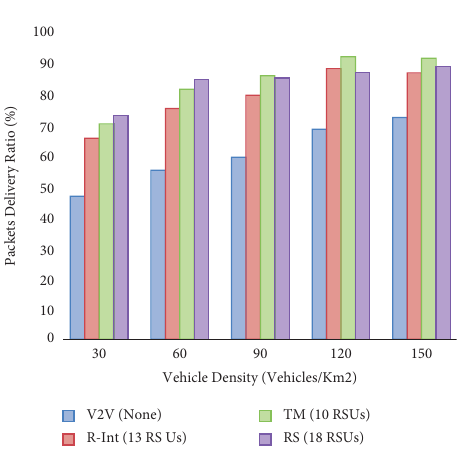
Figure 21: Packets delivery ratio (%).